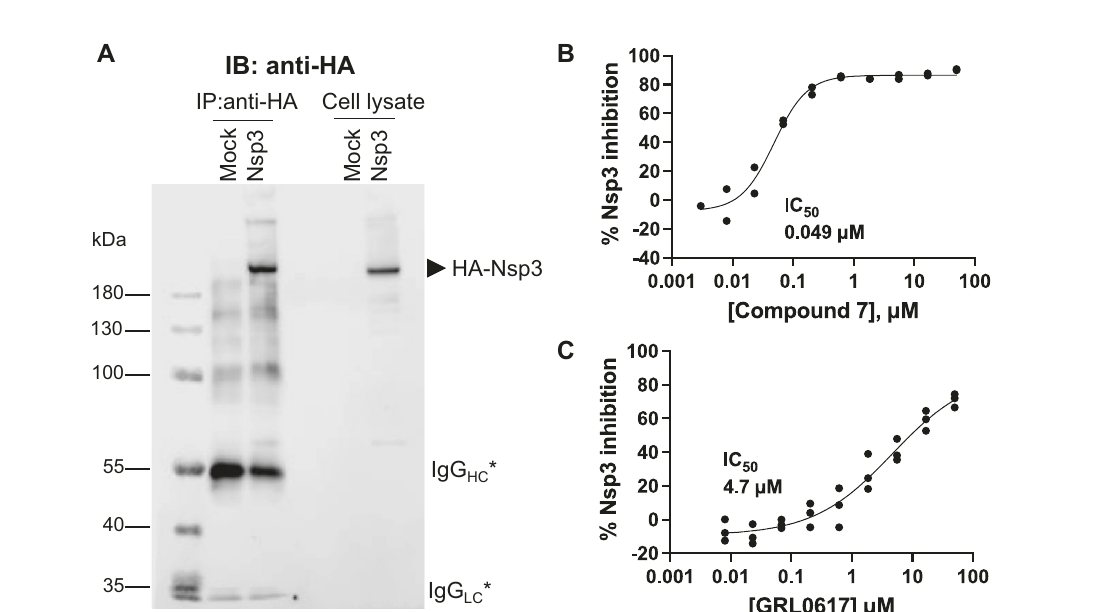
representsthelinearregressionyieldingasitsslopethesecond-orderrateconstant ( k inact /K I ). c IntactproteinESI-MSspectraofPLpro(black)andPLproincubatedwith 7 (red);a.i.,arbitraryintensity;m/z,mass-to-chargeratio. d PercentviabilityofVero E6cellsafter48hfollowingpretreatmentwith 7 (blacksquares),pretreatmentwith 7 and infectionwith SARS-CoV-2 (red circles),or pretreatment with remdesivirand infected with SARS-CoV-2 (blue triangles). Data are plotted as the mean of n =2 independent samples. EC 50 is the concentrationatwhich 50%effectwasobserved. Curves are nonlinear regressions to the normalized dose response equation. Source data are provided as a Source Data fi le.